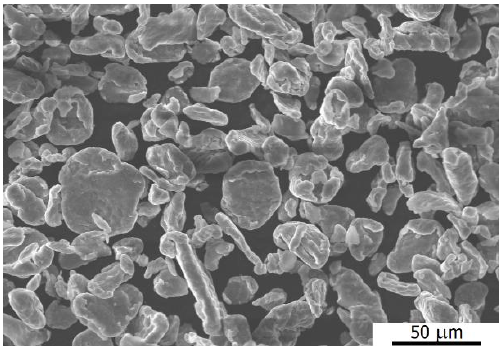
Figure 1. Magnesium powder particles; SEM.